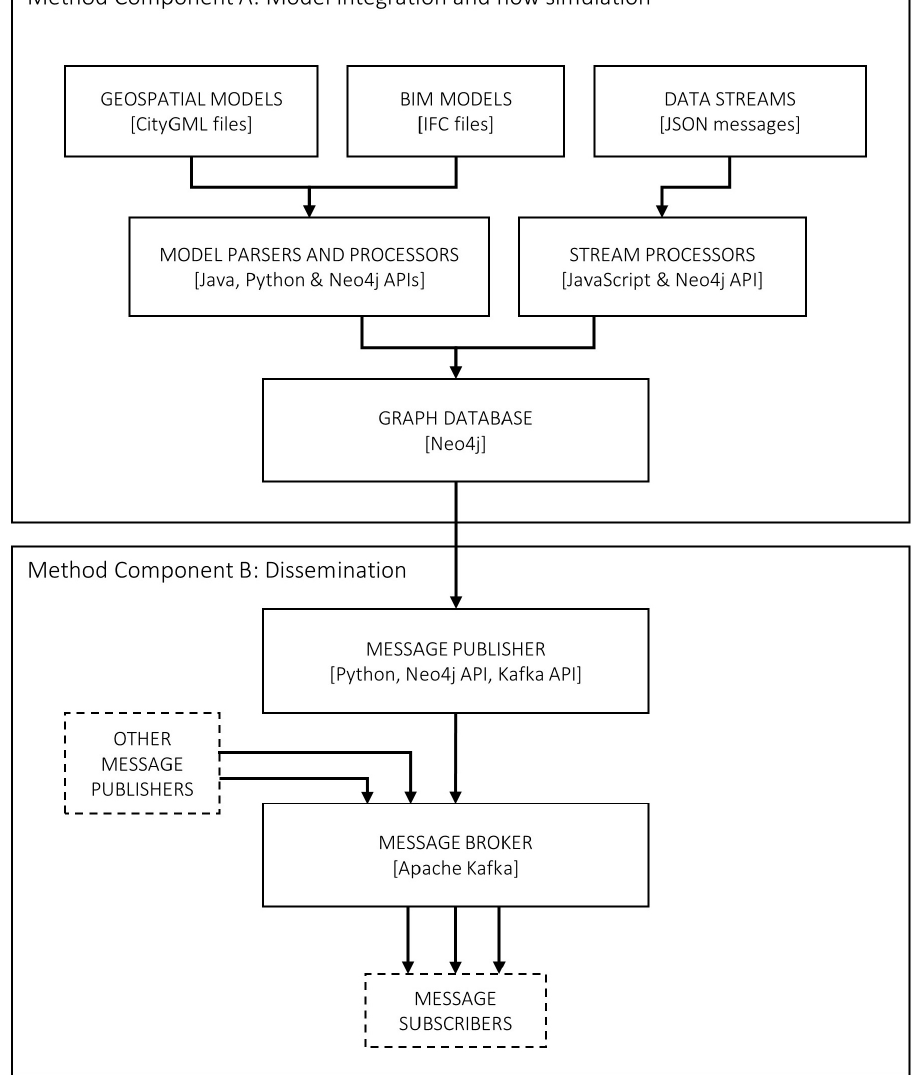
Figure 1. A depiction of the integration, simulation and dissemination method used in this research. In the system, extracted elements and their topological connectivity are pushed to a Neo4j graph database. A graph database was selected as they have been found to be efficient for storing and querying topologically connected data [24,25]. Furthermore, it has been proposed that graph theory and graph models are suitable for understanding urban topologies [26] and integrating models of urban data [27], and that graph databases can be used for the detection of spatial ‐ semantic changes in CityGML documents [28]. The sub ‐ networks derived from each data source are integrated into a single network by executing Neo4j Cypher queries that run ‘merge’ clauses on building nodes with matching identifiers across the CityGML and IFC files, and JSON stream. The sub ‐ networks are integrated by their connection to a common building node and the use of the merge clause (rather than the ‘create’ clause) avoids duplication by only creating a node if it does not already exist in the database. For the CityGML files, the GML IDs of the building nodes are used for unique identification; for the IFC files, the name of the IfcBuilding element is used; for the JSON stream, the structure of the messages determines which key ‐ value pair/s should be used for the unique